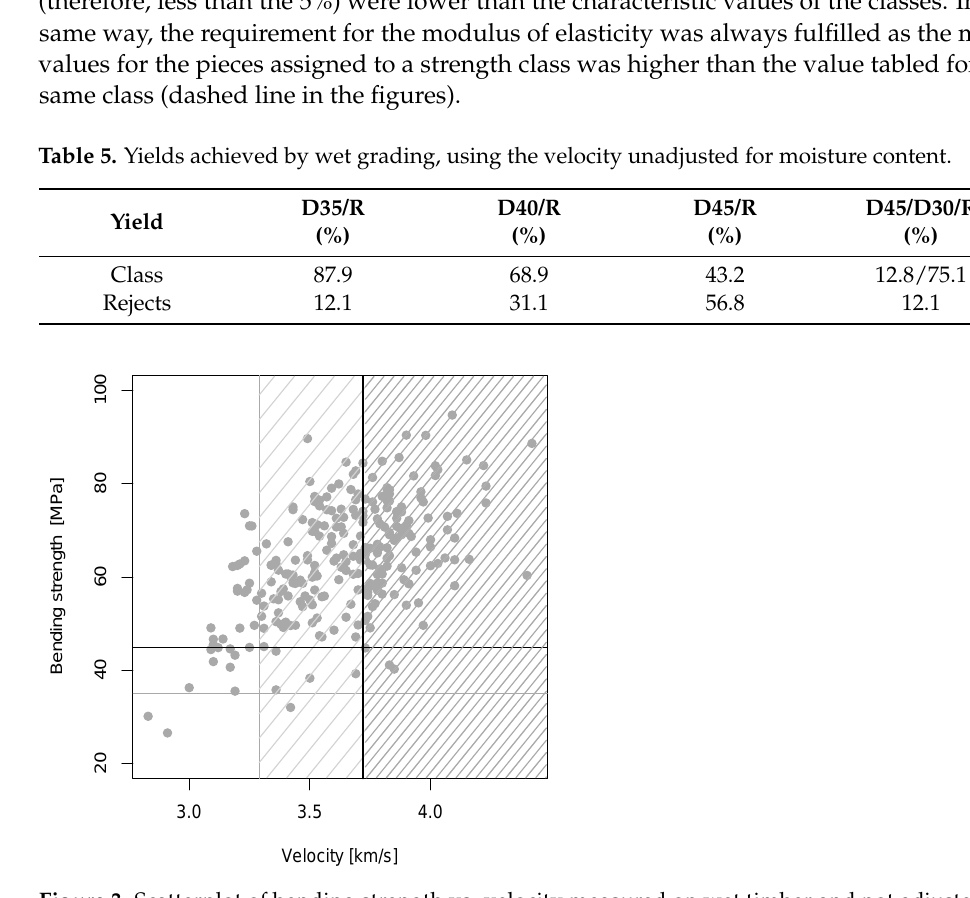
Figure 3. Scatterplot of bending strength vs. velocity measured on wet timber and not adjusted for moisture content. Vertical lines = settings recalculated at 40% MC for D35 (grey) and D45 (black); horizontal lines = characteristic values of strength for the classes D35 (grey) and D45 (black); sparse oblique lines = pieces assigned to D35; dense oblique lines = pieces assigned to D45.